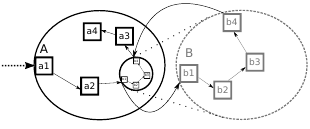
Figure 8: The two models have been composed. Process B has now been substituted for the delay action in process A The delay in process A simulates the time that would have elapsed if the model were more detailed. This detail is present in the com- posed model and so the delay is no longer